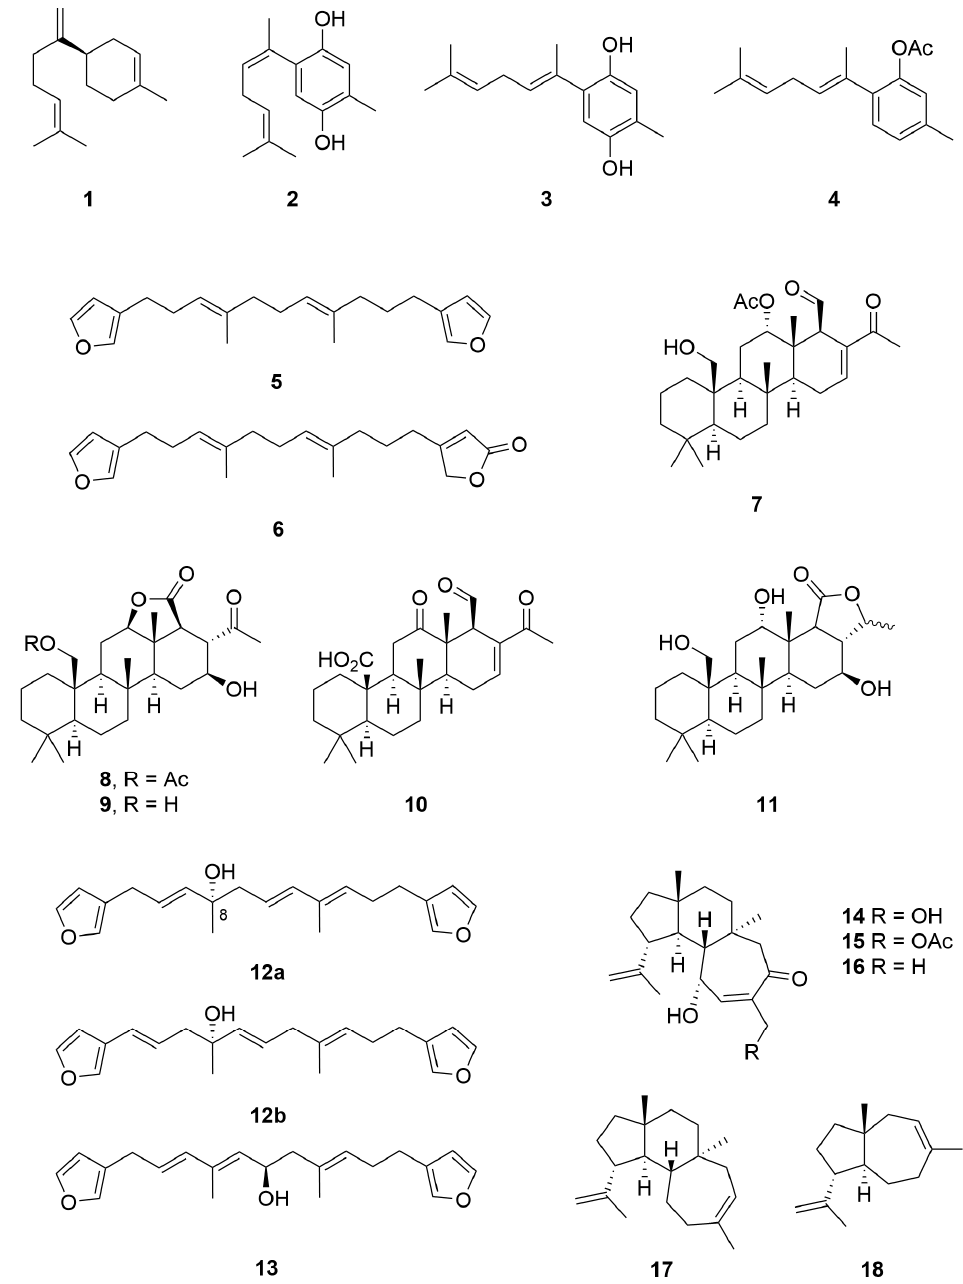
Figure 1. Compounds 1 to 18